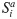
The 15 Sia’s arranged in decreasing order of their magnitudes.